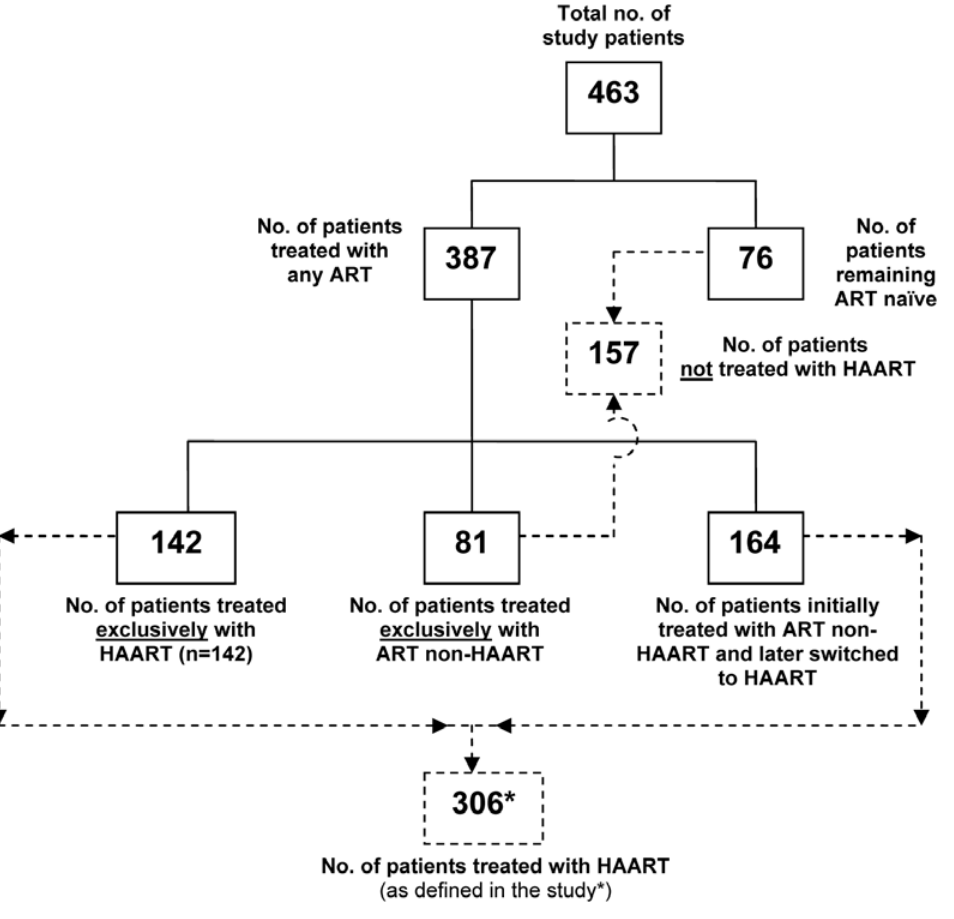
Figure 1. Breakdown of study patients attending public HIV treatment facilities in Brazil (n=463) between January 1, 1995 and December 31, 2001 by intervention (HAART, ART non-HAART), and non-intervention (ART naı¨ve).